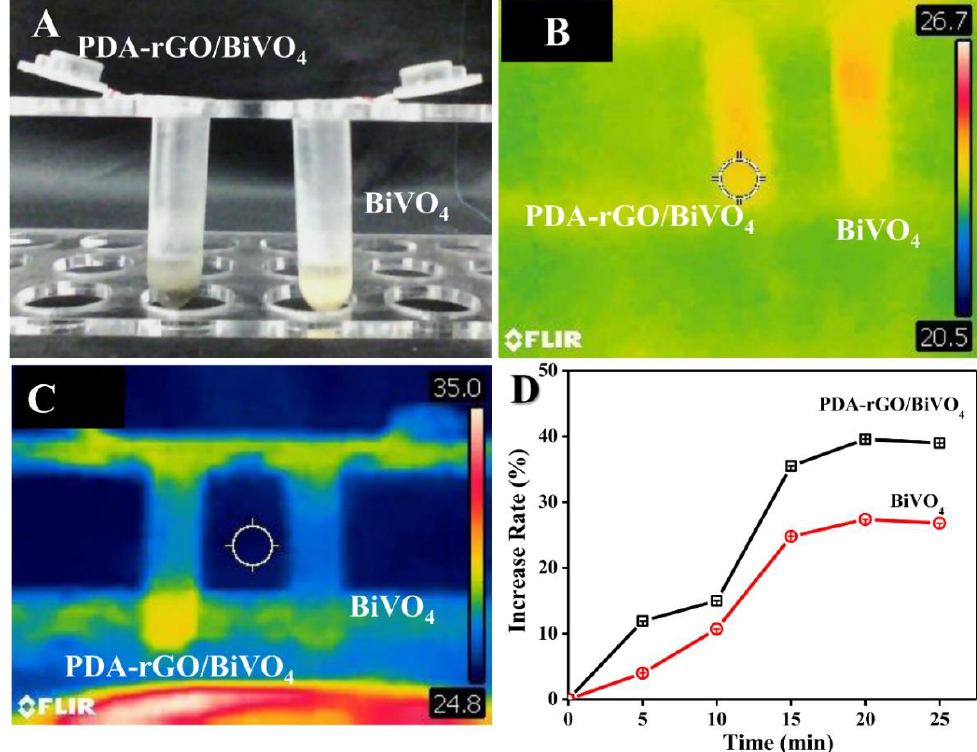
Figure 2. ( A ) Photograph and ( B ) infrared thermal images of the BiVO 4 and PDA-rGO/BiVO 4 com- posite dispersed in double-distilled water before xenon lamp exposure. ( C ) Infrared thermal images of the rGO/BiVO 4 composite after xenon lamp exposure for 10 min. ( D ) Measured temperature of the composite calculated from infrared thermal images. The symbols are increase rates of BiVO 4 and PDA-rGO/BiVO 4 .